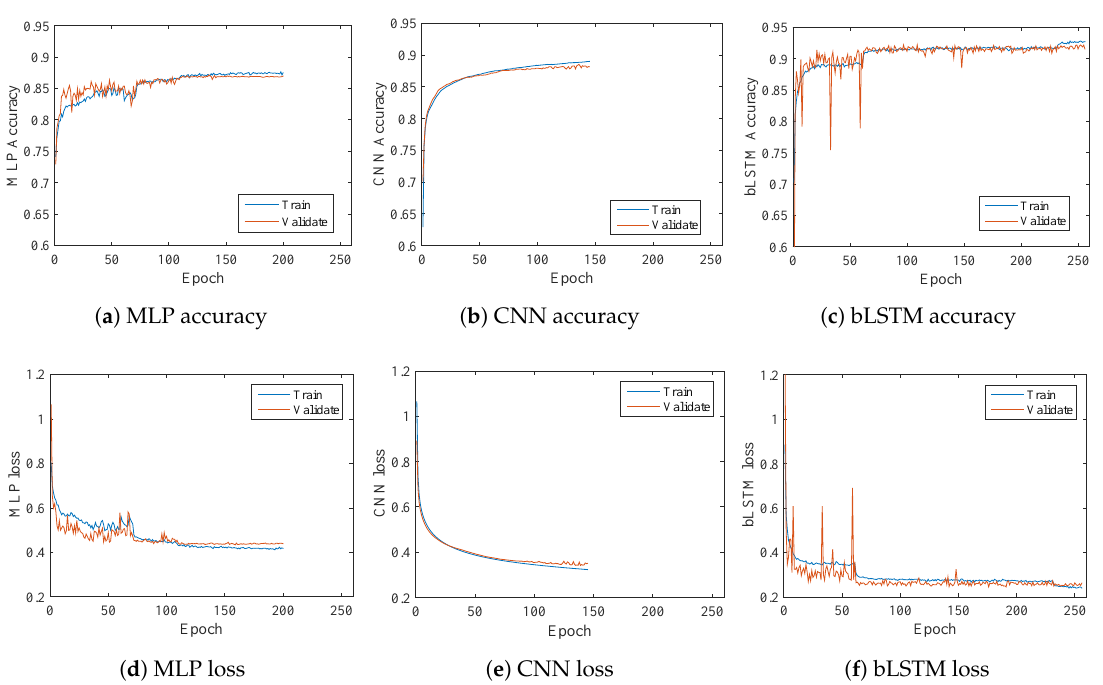
Figure 12. Training profile on the feature set by three deep learning models. ( a ) and ( d ): training on MLP. ( b ) and ( e ): training on CNN. ( c ) and ( f ): training on bLSTM. Both training and validation results are shown in the above